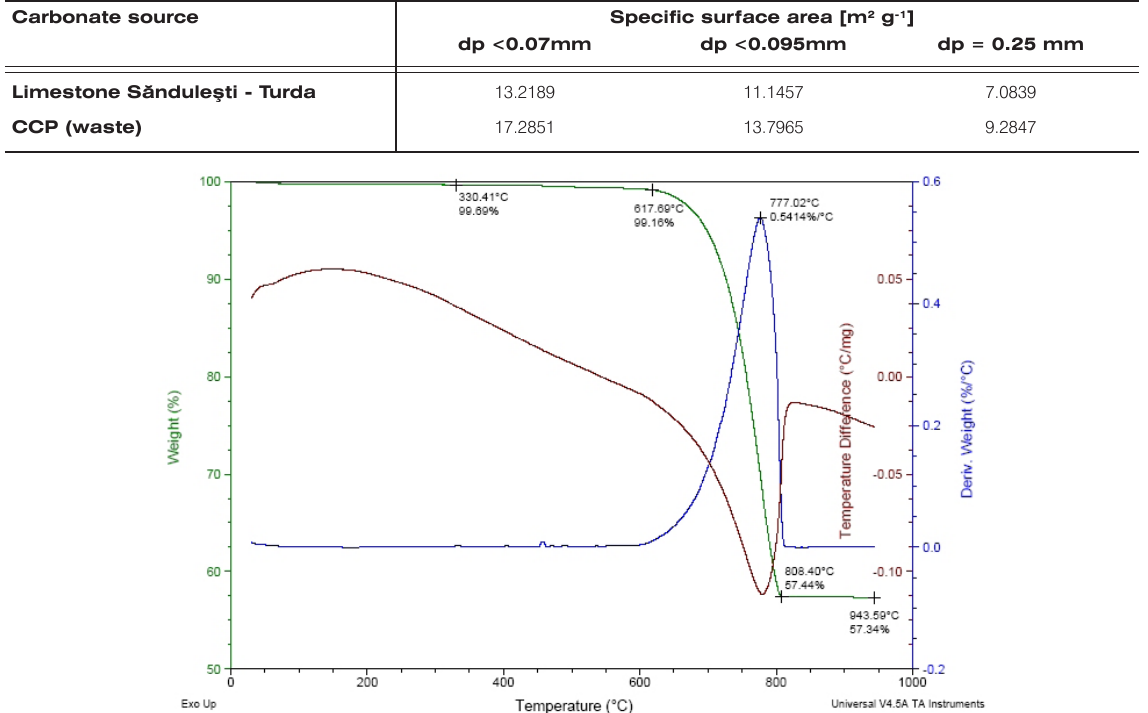
Table 3. Specific surface area of limestone and